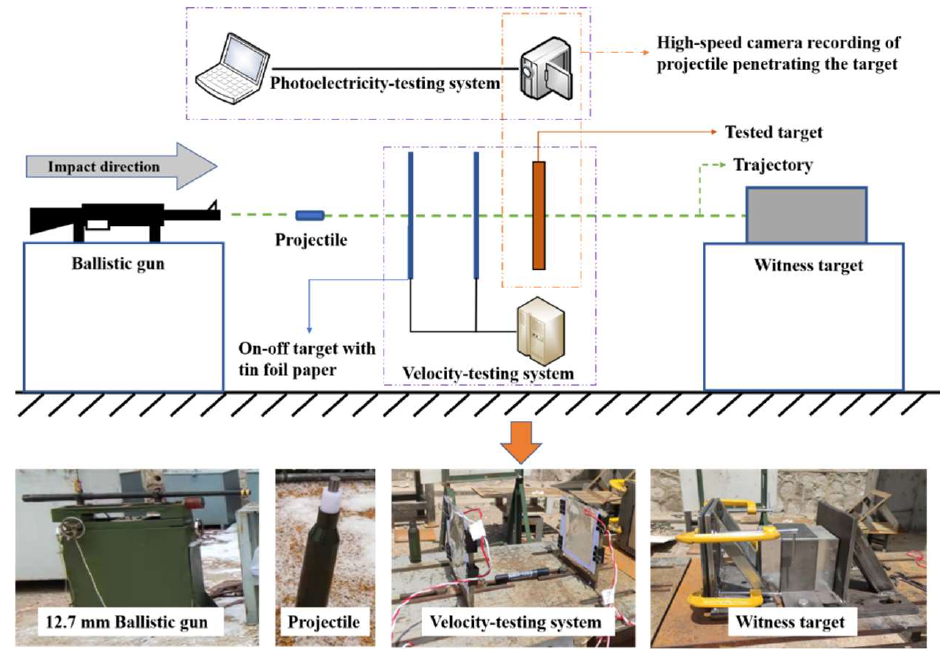
Figure 2. Experimental device layout.